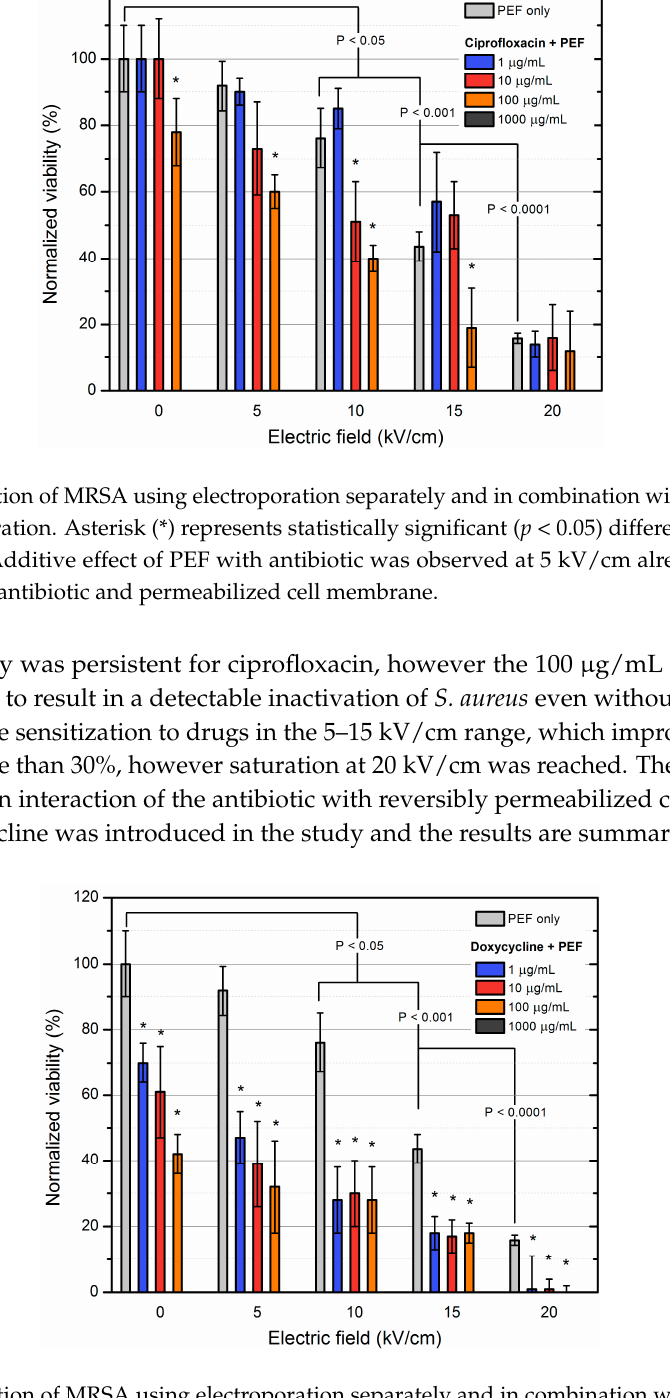
Figure 4. Inactivation of MRSA using electroporation separately and in combination with doxycycline of varied concentration. Asterisk (*) represents statistically significant ( p < 0.05) difference versus PEF only treatment. The bacteria sensitization phenomenon was detectable in the whole range of applied